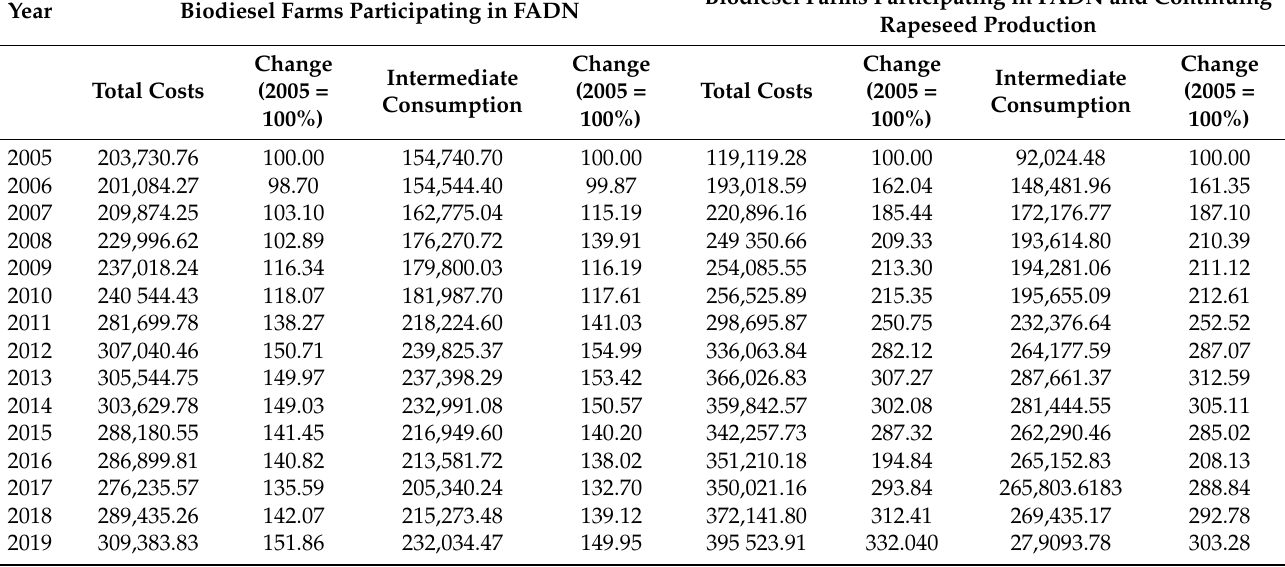
Table 6. Total costs (PLN) in Polish biodiesel farms from 2005 to